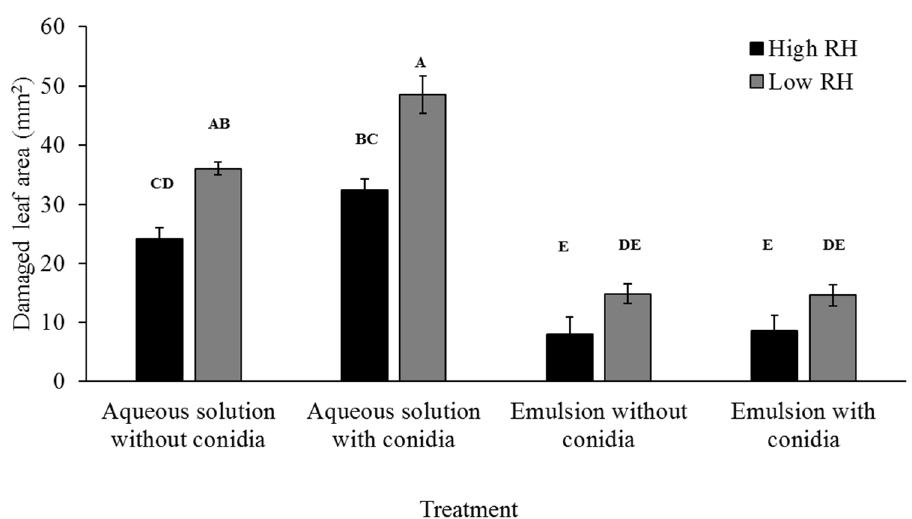
Figure 6. Mean leaf damage area in mm 2 ( ± SE) caused by S. littoralis larvae exposed to different treatments and RH. The damaged area was assessed after three days of larval activity on treated leaves. The damaged area was assessed by photographing the leaves alongside millimeter paper and then analyzed using the ImageJ software. Different upper-case letters designate significant difference between experimental groups as tested via Tukey-HSD ( α < 0.05).